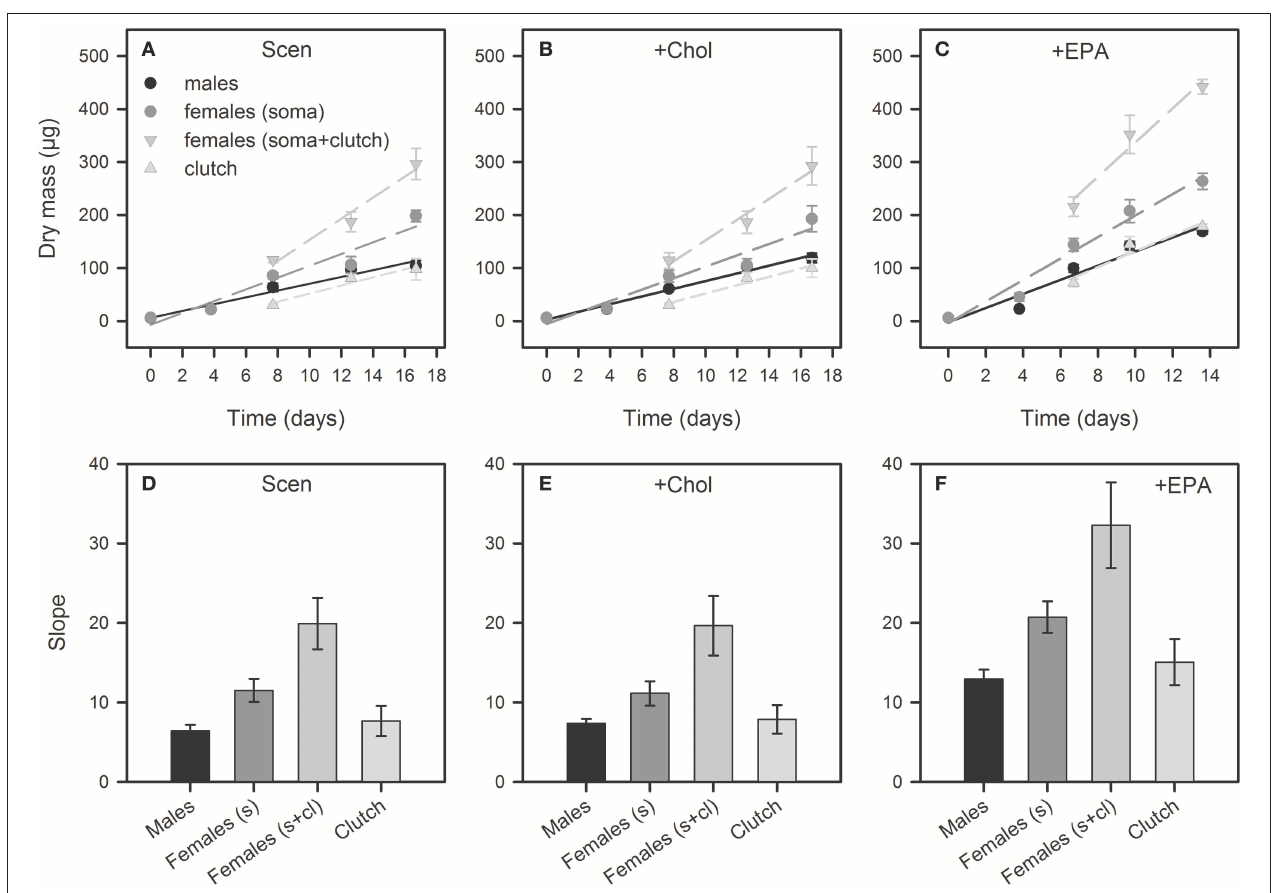
FIGURE 4 | Dry mass increase of female and male D. magna reared on S. obliquus (A) and S. obliquus supplemented with cholesterol (B) or EPA (C) . Females and males were subsampled at birth, at day four of the experiment, and when females deposited the first-, second-, and third-clutch eggs in their brood chambers. For dry mass determination and subsequent lipid analyses, eggs were removed from the brood chambers and female somata and eggs were weighed and analyzed separately. Clutch data represent the total female dry mass investment in egg production in the first, second and third reproduction cycle, respectively. The total dry mass of females was calculated by adding up soma and clutch dry mass (soma + clutch). Data in (A–C) represent means of n = 6 ± SD. The slopes of the linear regressions were used to assess sex-specific differences in dry mass increase (D–F) . Error bars in (D–F) show 95% confidence intervals (CI). Non-overlapping CIs indicate significant